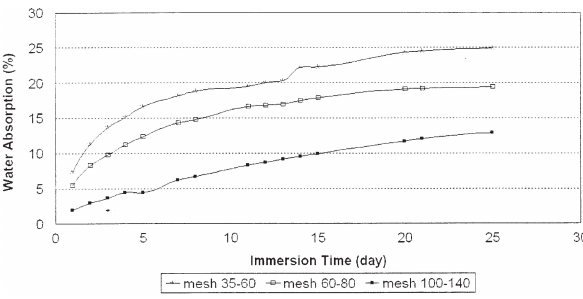
Figure 10: Variation of water absorption rate with immersion time for 57% RH [32]